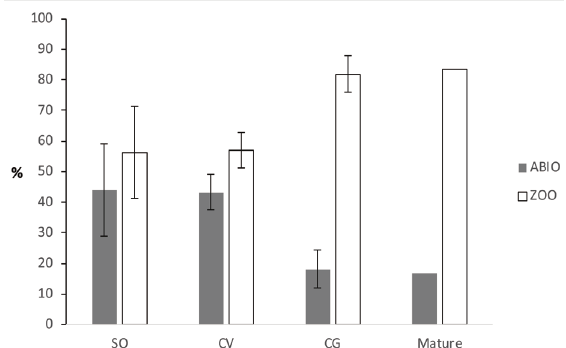
Figure 3 - Distribution of the percentage of species in ecological groups in the burnt forest fragments Sooretama (SO, 14-yrs after fire), Córrego do Veado (CV, 25-yrs after fire), Córrego Grande (CG, 25-yrs after fire) and an adjacent mature forest (Paula and Soares 2011), State of Espírito Santo, Brazil. PI – pioneers, SI – early secondary and ST – late secondary.